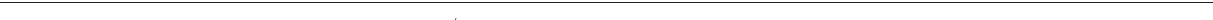
FIGURE 7 | 4 independent experiments. (B–D) WT or Irf1 − / − mice bearing subcutaneous (s.c.) B16F10 melanoma tumors were treated with MEKi-A or intratumoral (i.t.) R848 or both as indicated in (B) . (C,D) Survival analysis (C) and tumor growth (D) of WT or Irf1 − / − melanoma-bearing mice treated with MEKi-A and/or R848. Data from at least 9 mice/group are pooled from 2 to 3 independent experiments. (E) Heat map showing mRNA expression of 36 genes identified with significant associations between their expression levels and patient survival. Data presented are from individuals with overall survival shorter than 321 days ( n = 50) or longer